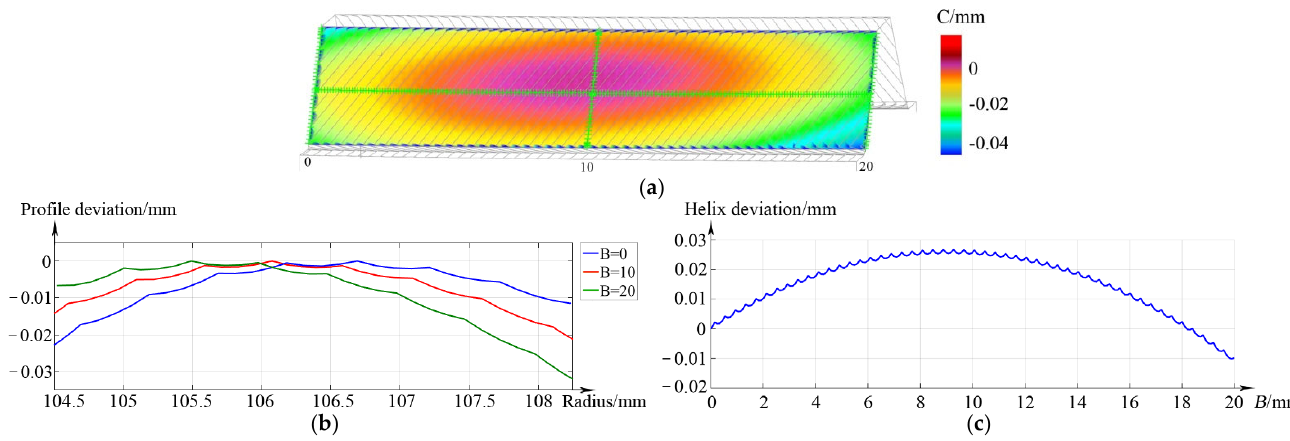
Figure 7. Measured deviations of the tooth flank enveloped via general skiving method. ( a ) deviation contour plot, ( b ) profile deviation, ( c ) helix deviation.